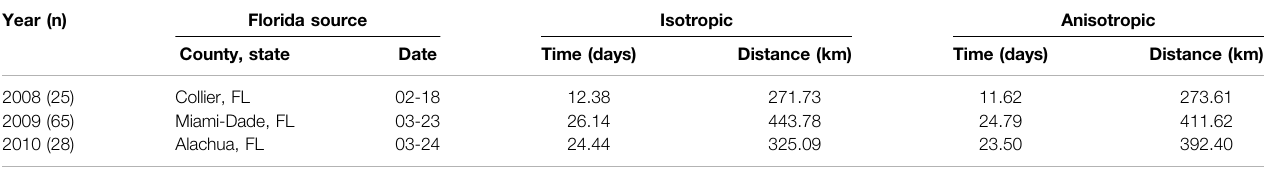
TABLE 6 | Root mean square errors of time and distance for isotropic and anisotropic one-source models. The source location and time of appearance, shown in the table, are the earliest occurrences among all sentinel plots in the data for the corresponding year ( n is the sample